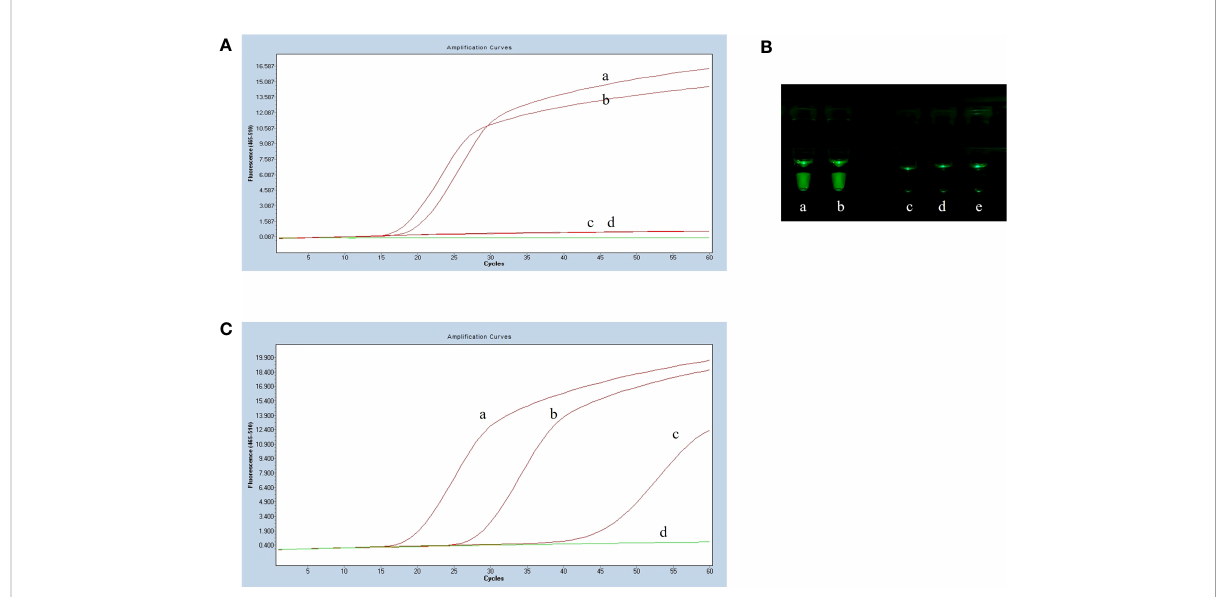
FIGURE 2 Results of establishing the basic reaction system. (A) Fluorescence ampli fi cation curve of the basic reaction. (B) Observing the basic reaction result with a 3D printed visual function box. (a) Streptococcus suis serotype 2 genomic DNA, (b) Streptococcus suis serotype 14 genomic DNA, (c), (d) and (e) Negative control. (C) The effect of the usage of the swarm primers. (a) LF primers and SF primers, (b) LF primers, (c) SF primers, (d) Negative